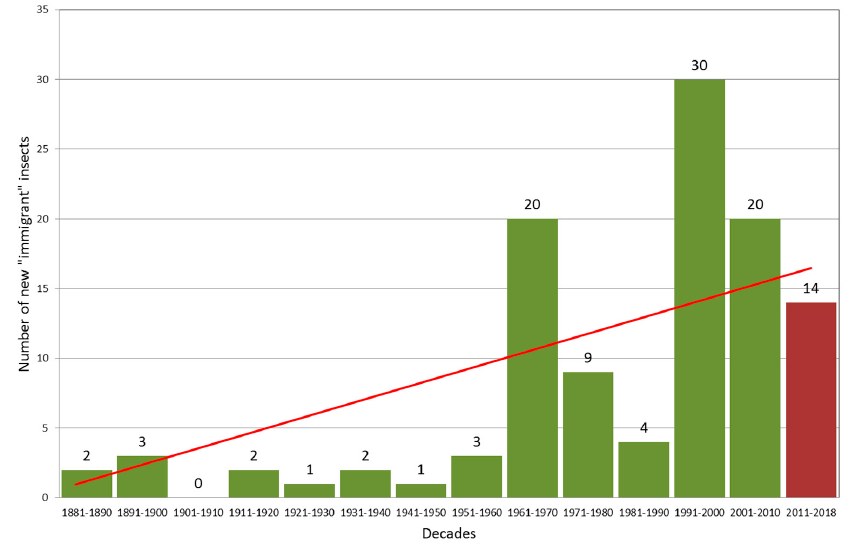
Figure 7. Newly recorded immigrant insects on woody plants by decades in Hungary between 1881 and 2018 (updated from Csóka et al. [62]).